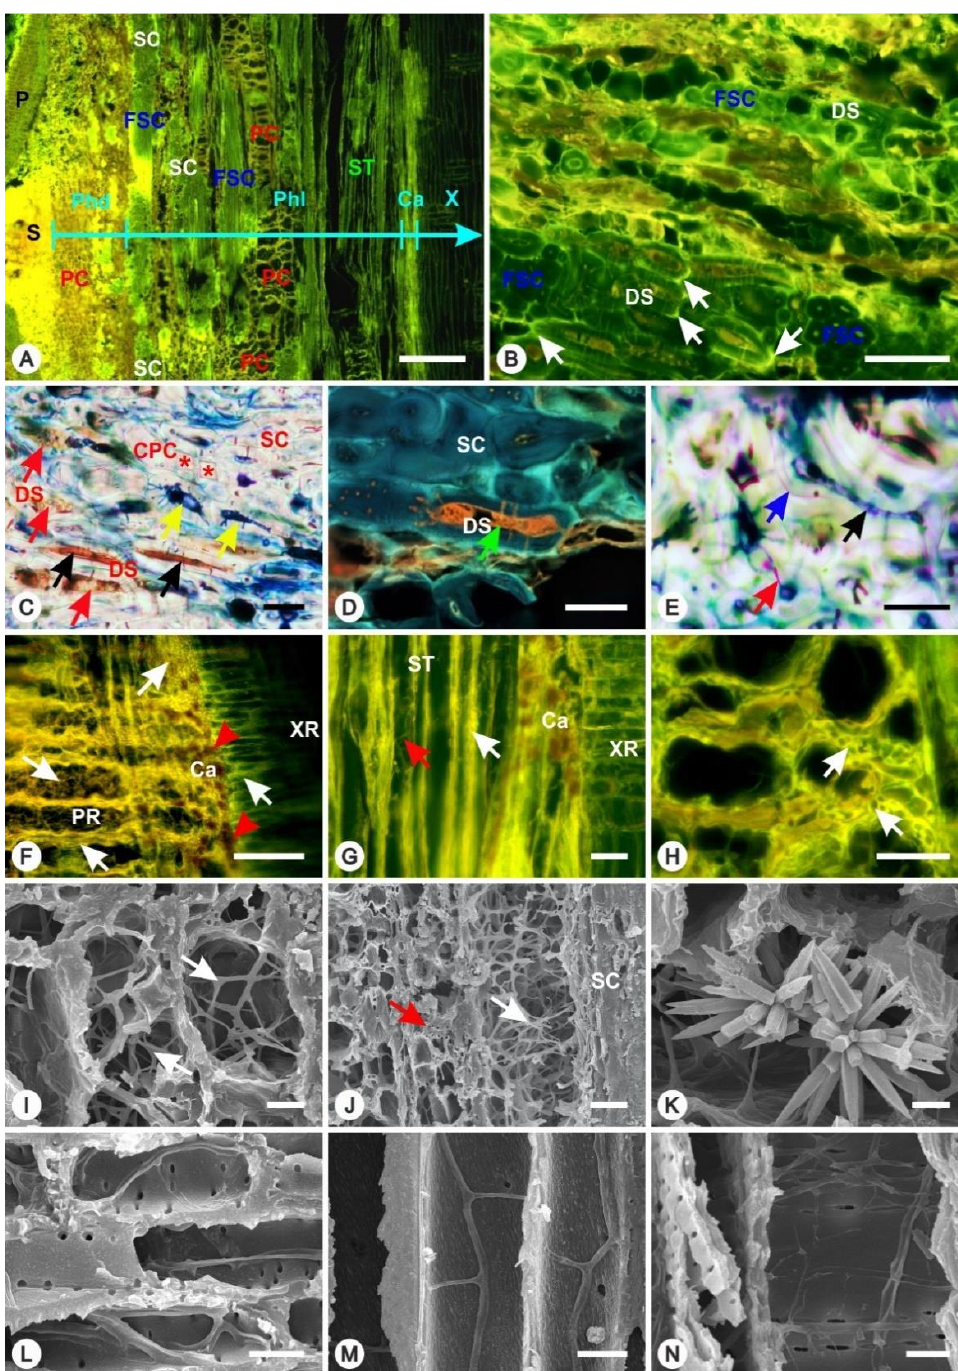
Figure 4. Histopathological assessments of the phloem and xylem tissue disintegration using fluorescence ( A , B , F – H ), light ( C , E ), confocal laser scanning ( D ) and scanning electron ( I – N ) microscopies. ( A ) The spread of the fungal infection through the parenchyma cells and the sclereid clusters of both phelloderm and phloem layers towards the cambium and xylem tissues. Yellow color denotes the hyphae aggregates in phelloderm and the disintegration of green colored lignocellulosic cell walls. Brown coloration indicates the presence of polyphenolic compounds in the parenchyma cell walls of both phelloderm and phloem. Radial section. ( B ) Developing sclereids, located between two mature fibre-sclereid clusters, restricted the spread of the infection (yellow colored areas) into the inner phloem tissues. However, some hyphae penetrated also into the mid- dle lamellae of developing sclereids (white arrows). Cross-section. ( C ) Different types of polyphe- nolic compounds (red, black and yellow arrows) or inorganic crystals (asterisks) found inside the lumens of developing sclereids and mature sclereid clusters or crystalliferous parenchyma cells.